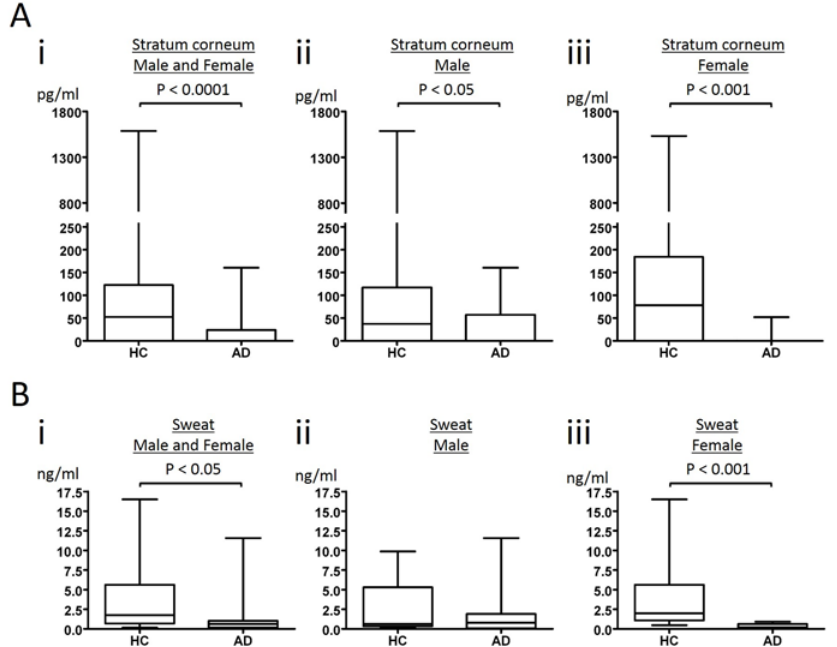
Fig 1. GCDFP15 levels in stratum corneum and sweat. Stratum corneum (SC) extracts (A) and sweat samples (B) were obtained from healthy control (HC) and atopic dermatitis (AD) individuals (i; male and female, ii; male, iii; female). GCDFP15 in SC extracts and sweat was quantified by ELISA. The results are expressed in box plot. The rectangle spans the first quartile to the third quartile. A segment inside the rectangle shows the median, and whiskers above and below the box show the locations of the minimum and maximum.